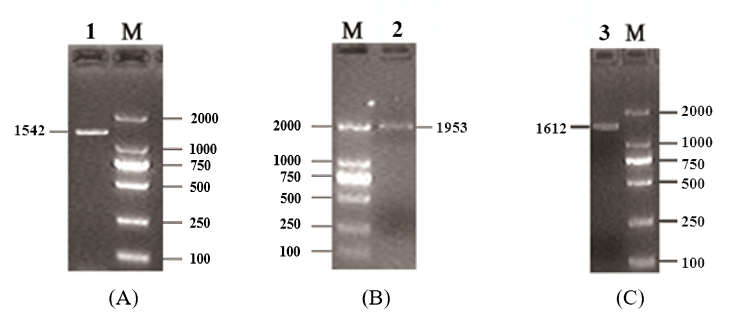
Figure 1. RT-PCR results for buffalo Smad1 ( A ), Smad4 ( B ), and Smad5 ( C ) genes. Lane 1, 2, and 3 are PCR products for the buffalo Smads 1 , 4 , and 5 genes, respectively. Lane M, DL2000 DNA